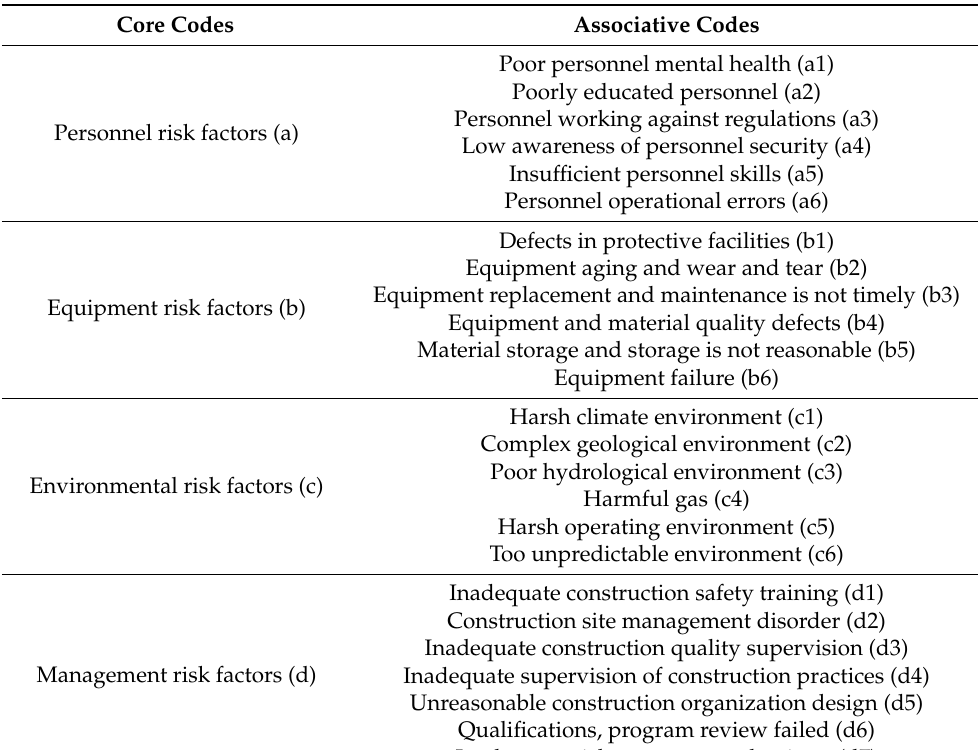
Table 3. Grounded theory core coding and associative coding list.